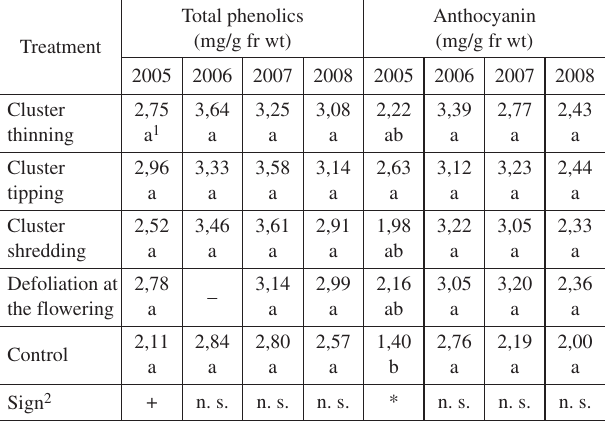
1 Means within columns followed by different letters differ significantly at p<0,05. 2 +, *, **, ns: significant at p<0,10, 0,05; 0,01, or not significant, respectively.